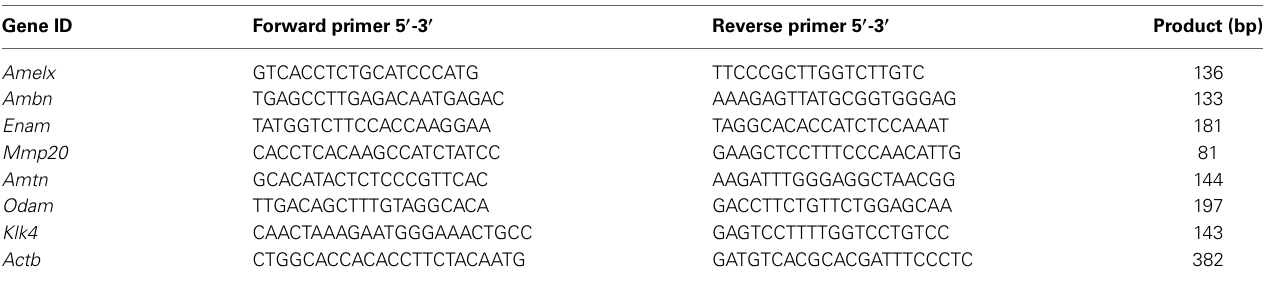
Table 1 | Primers used in this